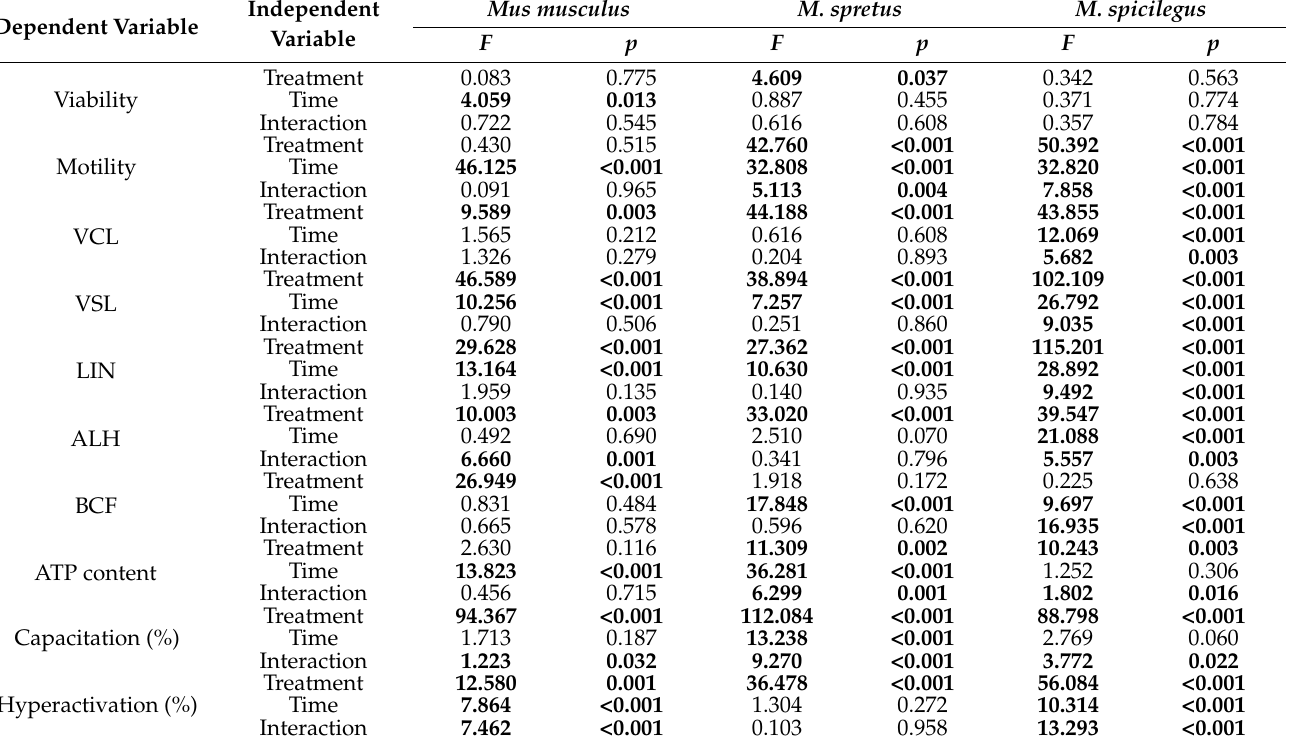
Table 1. Effect of time of incubation (“Time”), incubation conditions (“Treatment”: non-capacitating vs. capacitating), and interactions between time and treatment (“Interaction”) on viability, motility, percentage of capacitated cells, velocity parameters, ATP content, and hyperactivation in spermatozoa from M. musculus , M. spretus , and M. spicilegus . Values F and p correspond to repeated measure ANOVAs. Individual was used as a random factor, and incubation conditions and time were used as fixed factors. Results in bold show significant differences ( p < 0.05) in statistical analyses. VCL: curvilinear velocity; VSL: straight-line velocity; LIN: linearity; ALH: amplitude of lateral